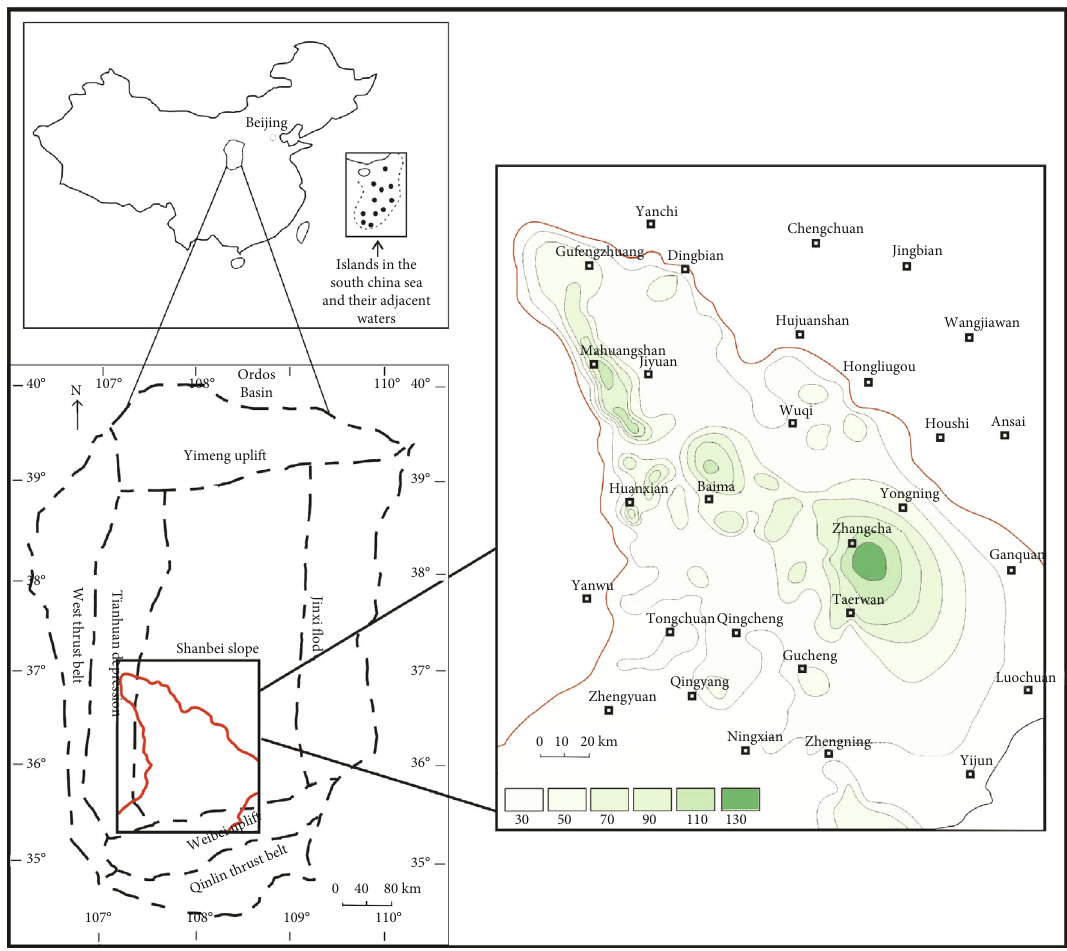
Figure 1: Location of the Ordos Basin and isopach map of the Yanchang Formation (contour intervals in